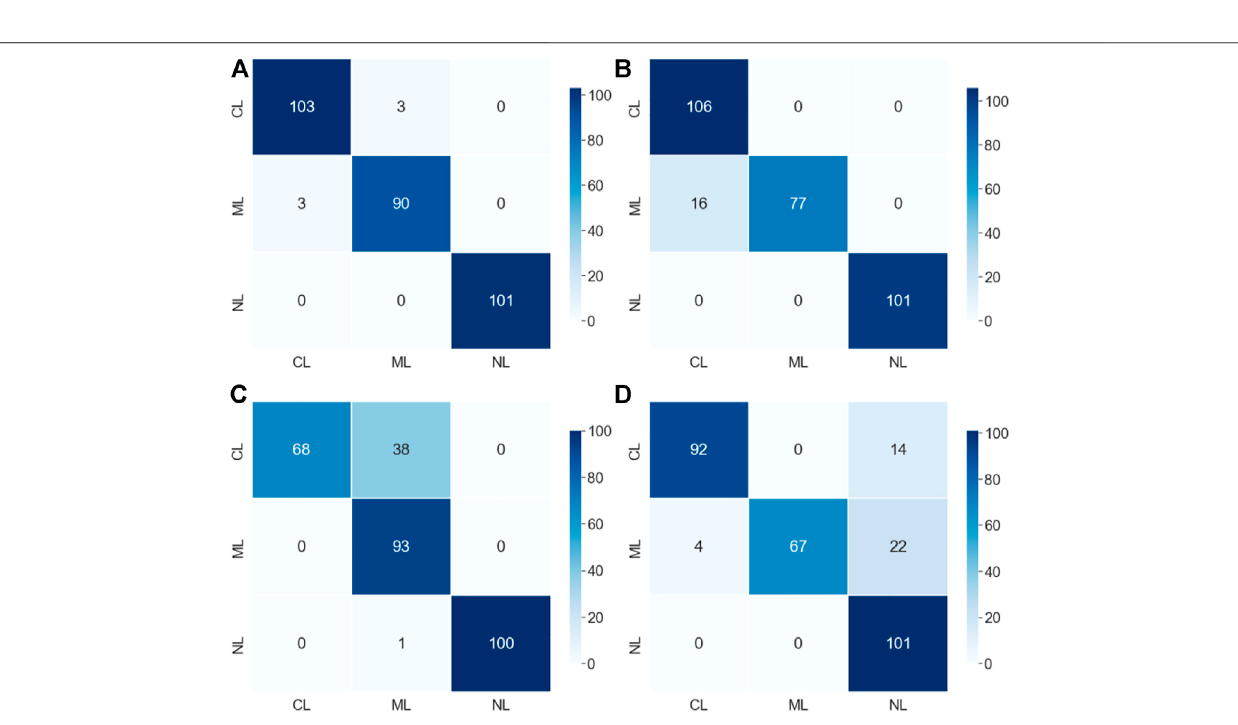
Frontiers in Materials |